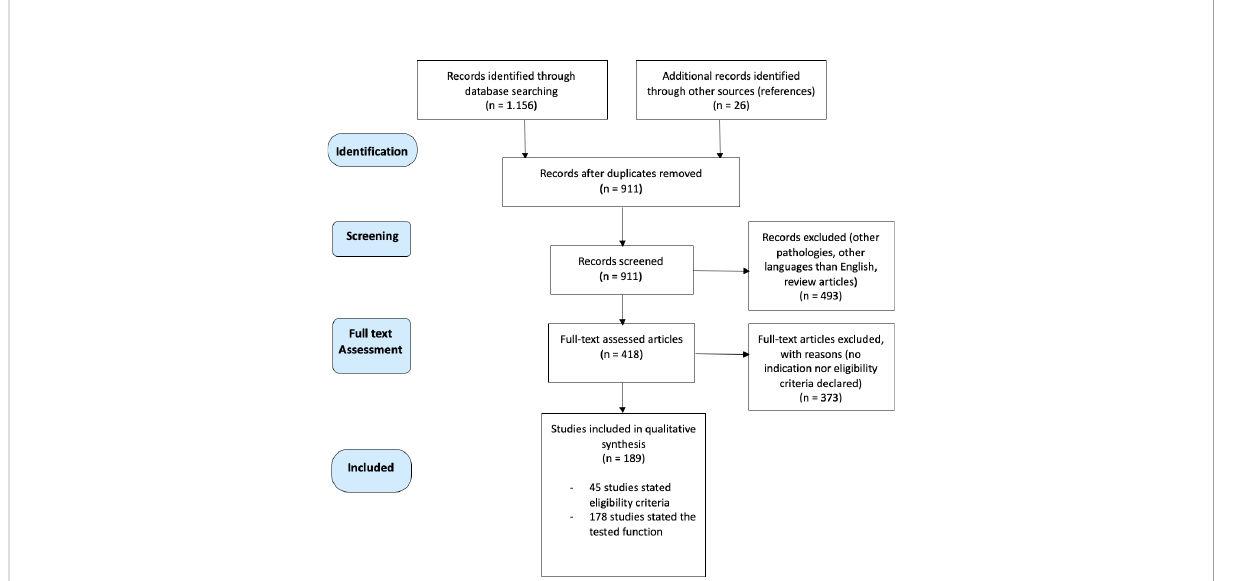
FIGURE 1 Flowchart of the selection process of this scoping review, according to PRISMA Statement Extension for Scoping Reviews